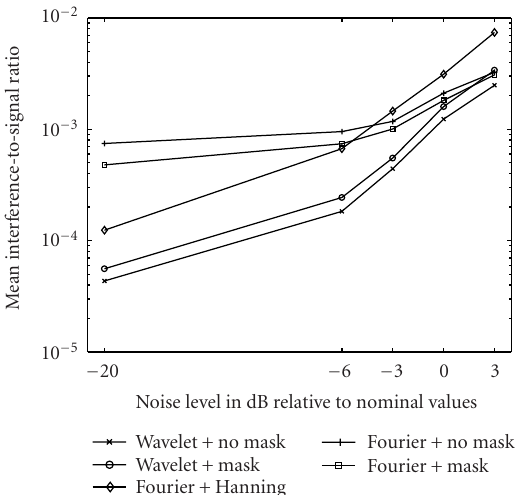
Figure 10: Comparison of the mean ISR for CMB as a function of noise in five di ff erent configurations, namely, wSMICA without mask, wSMICA with mask, fSMICA without mask, and fSMICA with mask, and fSMICA with Hanning apodizing window.